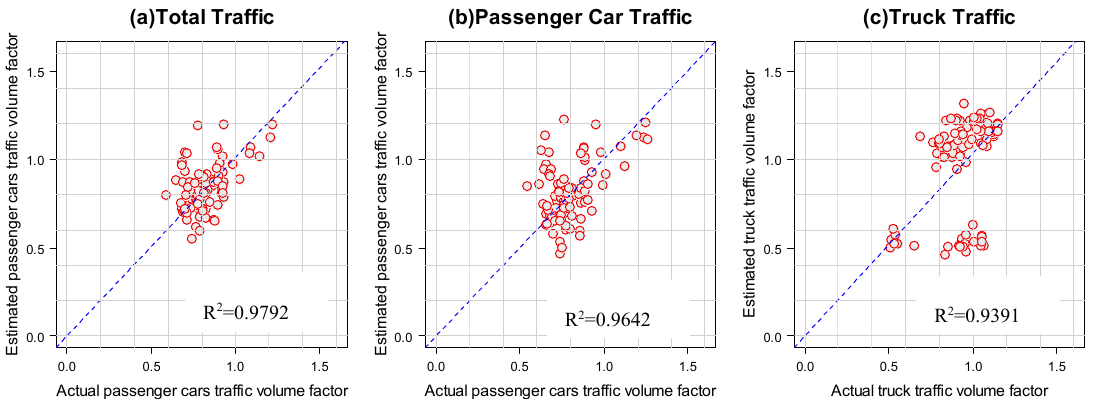
Figure 13. The accuracy of temporal transferability for dummy variable regression model at Leduc Highway 2.